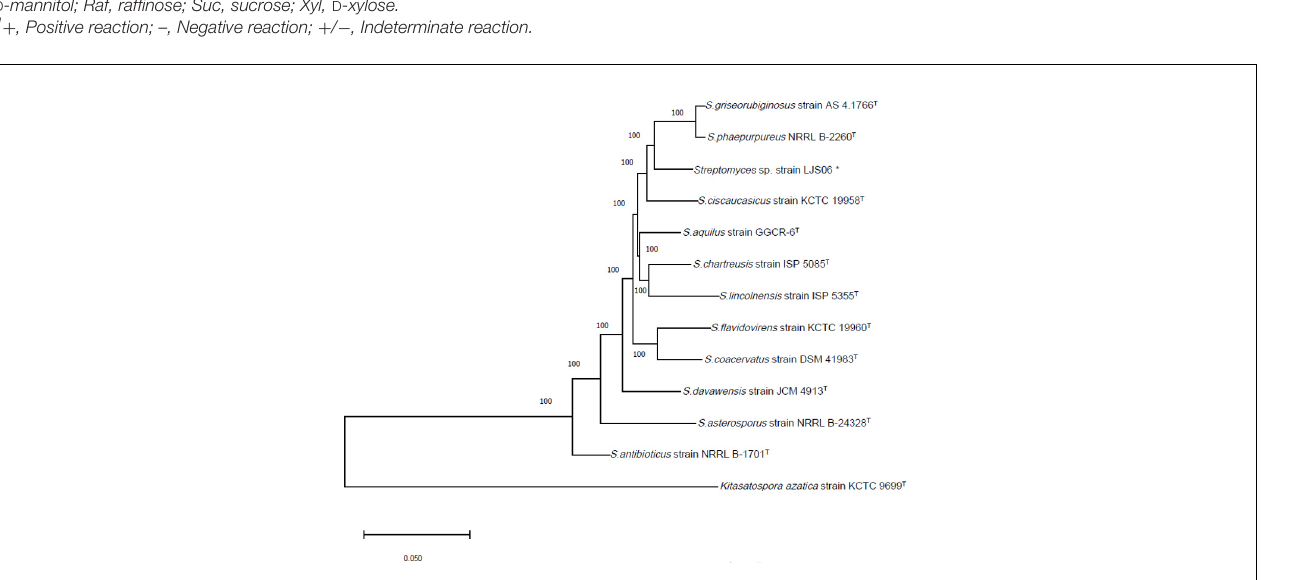
blue into highly fluorescent pink resorufin, thereby exhibiting the highest relative fluorescence unit ( p < 0.05) among all treatments ( Figure 6